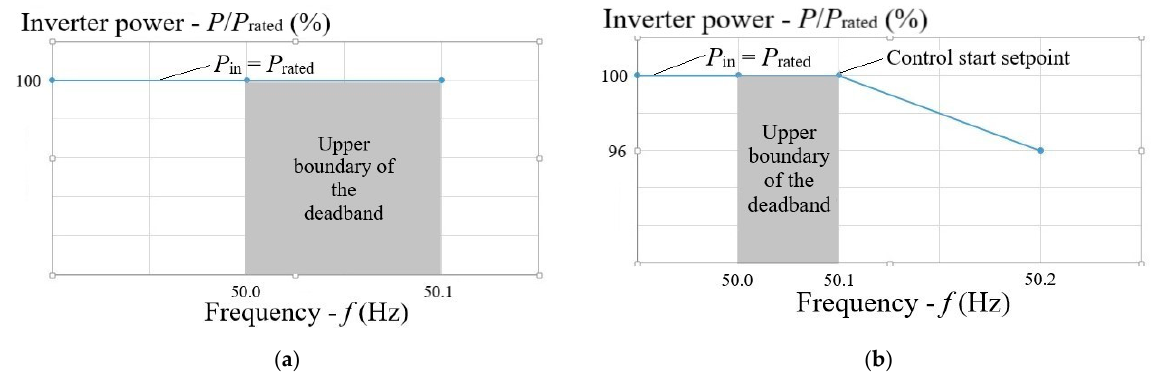
Figure 4. ( a ) A graph of testing the upper boundary of the deadband of the general primary frequency control; ( b ) a graph of power limitation by the inverter at f 1 = 50.2 Hz.